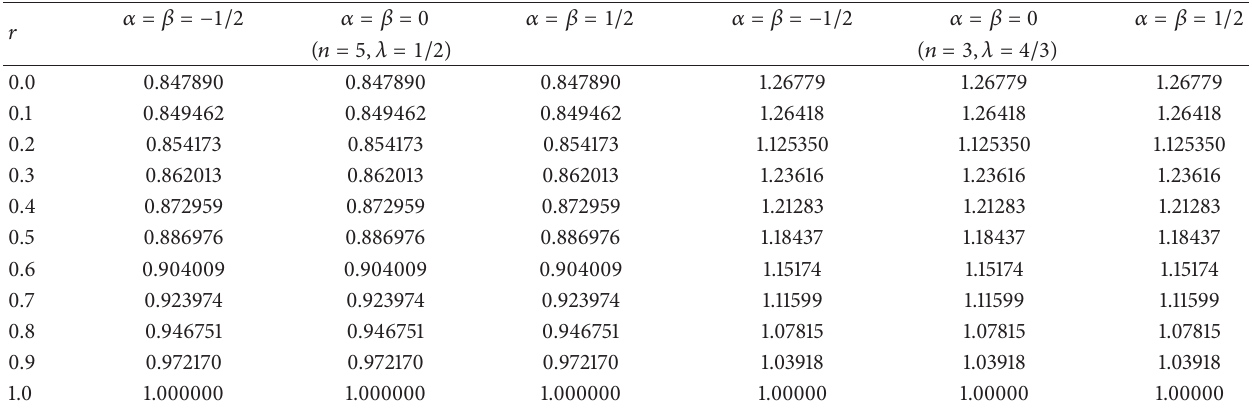
Table 1: Approximate solutions for 𝑁 = 24 .